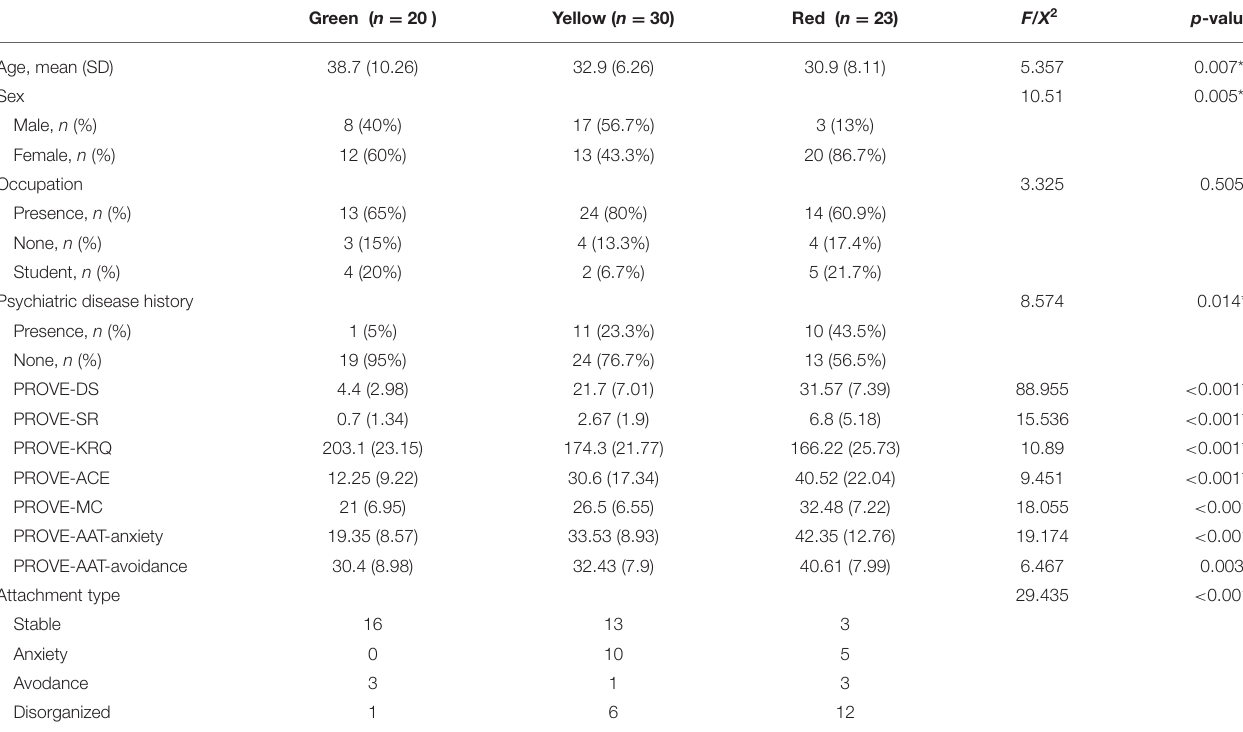
TABLE 1 | Demographic and psycho-social characteristics of groups by PROtective and Vulnerable factors battEry questionnaire.